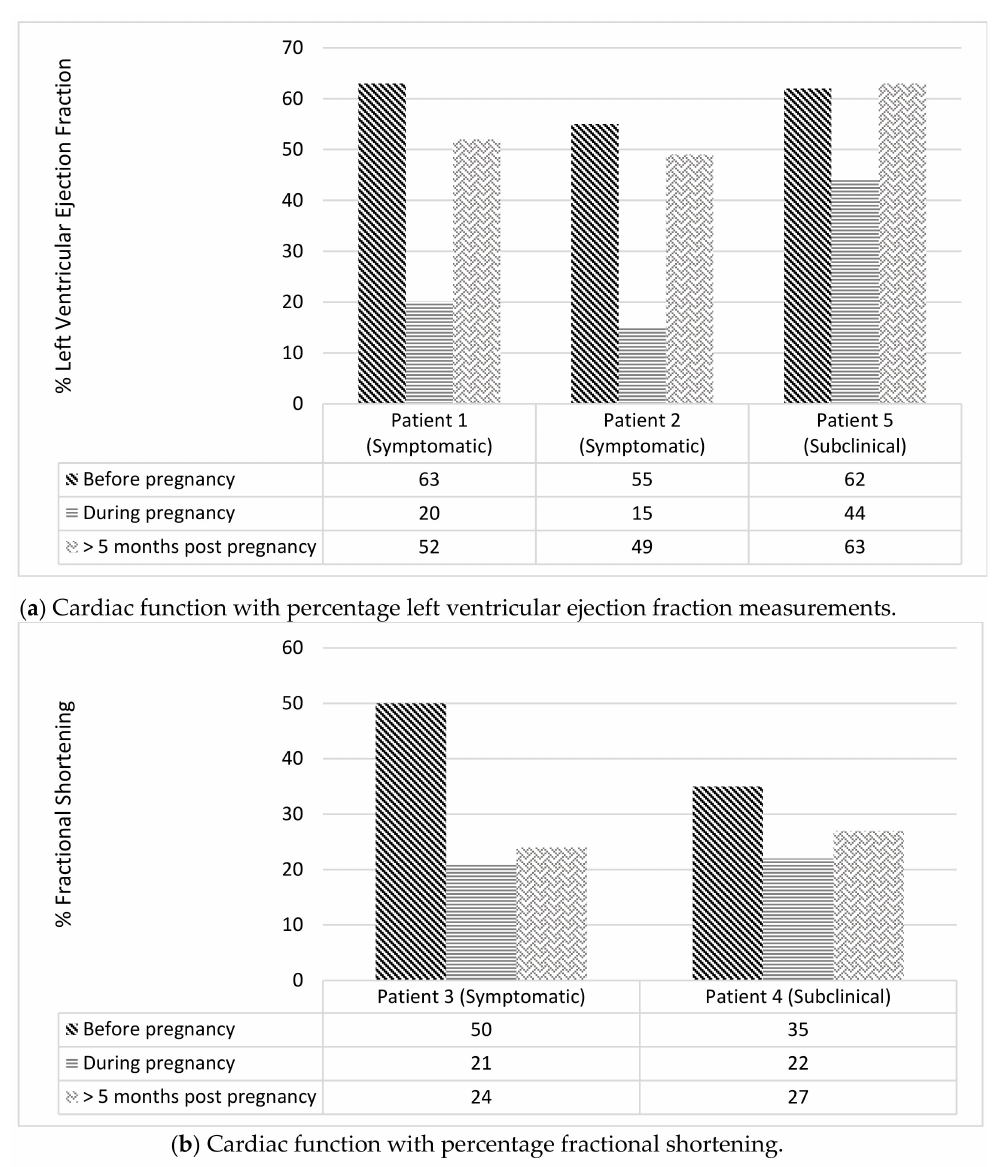
Figure 2. Cardiac function on transthoracic echocardiography and cardiac MRI (i) pre-, (ii) during and (iii) post-pregnancy in long-term survivors of malignancy with cardiac